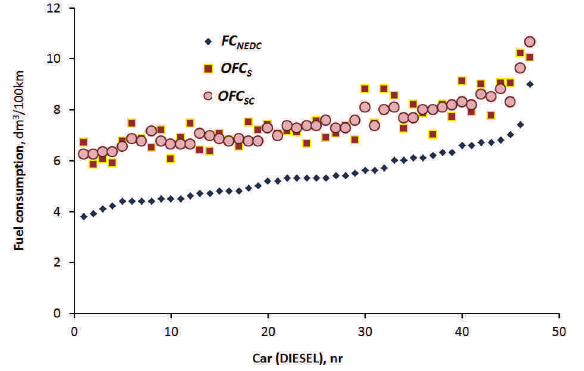
Fig. 7. Correlation of fuel consumption FC EUDC and in road test OFC S and calculated OFC SC of vehicles with compression ignition engines